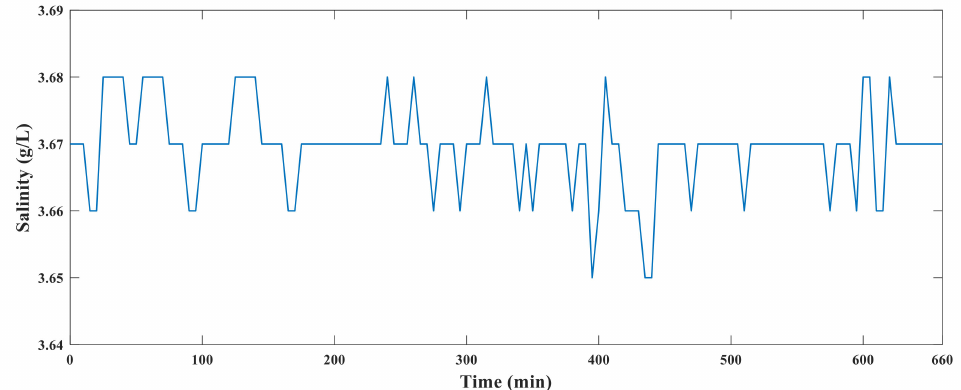
Figure 20. Results of high temperature